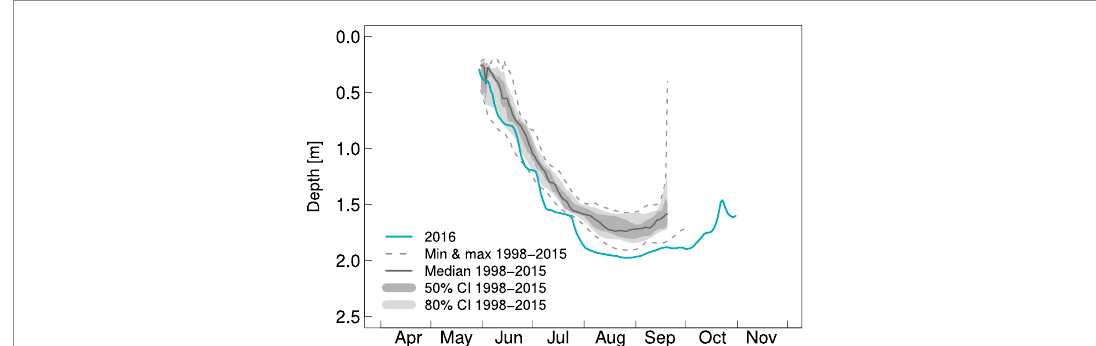
Figure 5. Development of the 0 ◦ C isotherm depth for Janssonhaugen for the year 2016. The year 2016 is shown in blue, and past minimum, maximum, median, and confidence intervals are shown in grey.